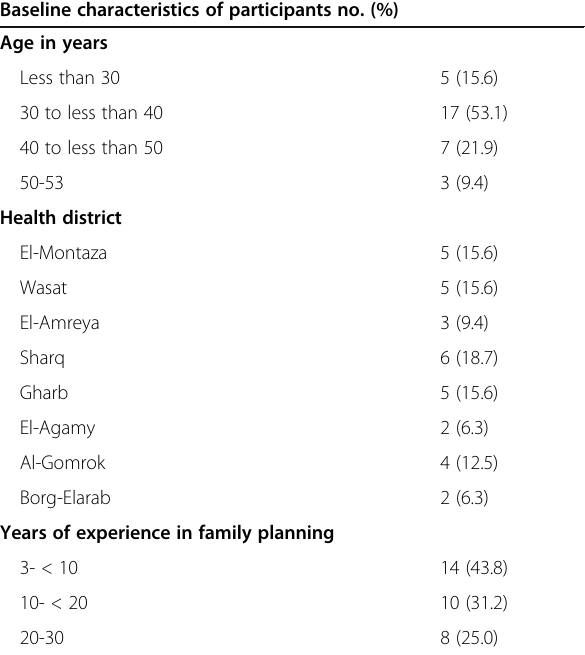
Table 2 Baseline characteristics of family planning providers working at public family planning clinics in Alexandria,